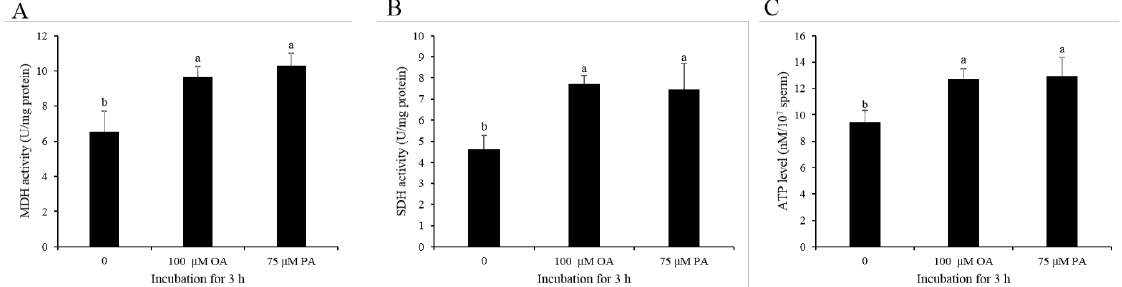
Figure 6. (A–D) Dynamic changes of CPT1 activity, ACADVL activity, and mitochondrial activity by the addition of OA and PA to the diluted medium at the 3h point of incubation: (A and B) CPT1 activity, (C and D) ACADVL activity, and (E and F) mitochondrial activity. Data are the mean ± standard deviation (SD). Columns with different lowercase letters differ significantly ( p ＜ 0.05).